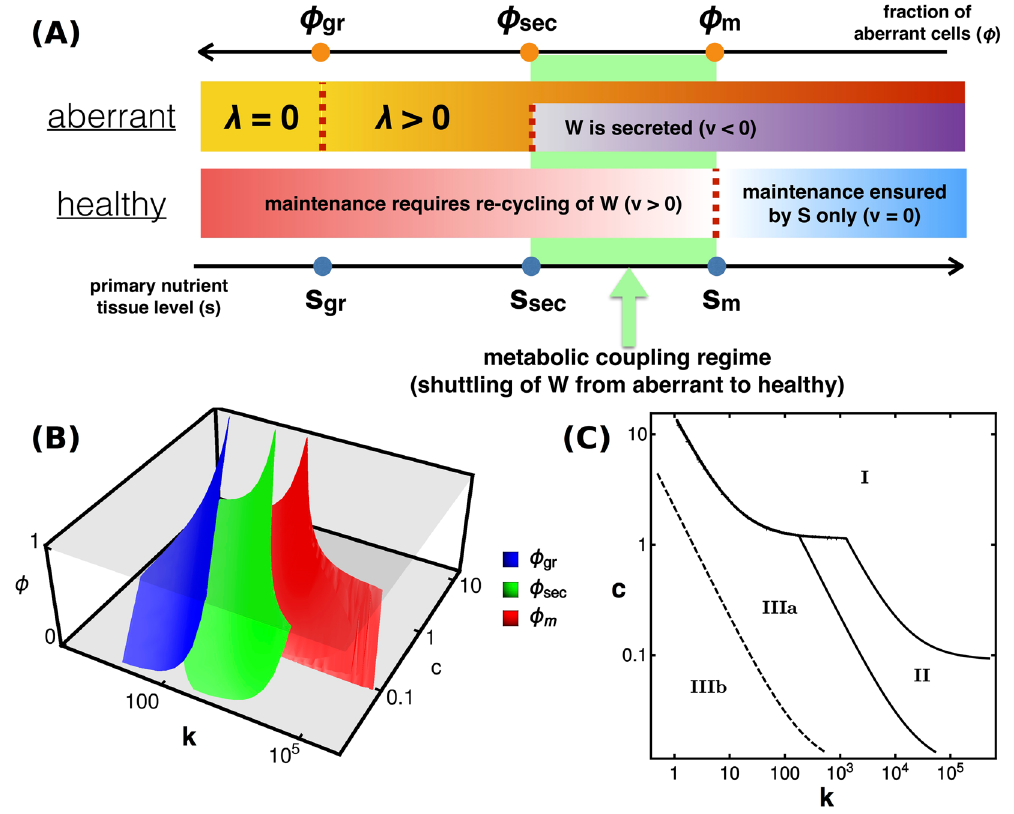
Figure 5. Summary of thresholds found in the spatially homogeneous model. ( A ) Aberrant cells can sustain a non-zero growth rate for s > s gr (or φ < φ gr ) and excrete waste for s > s sec (or φ < φ sec ). In turn, healthy cells need to re-cycle the waste in order to meet their maintenance goals when s < s m (or φ > φ m ). As a consequence, aberrant and healthy cells are coupled when s sec < s < s m (or φ m < φ < φ sec ). Note that the φ -axis (top) is reversed with respect to the s -axis (bottom). ( B ) φ gr , φ sec and φ m as functions of k and c . ( C ) Phase structure in terms of the asymptotic aberrant fraction φ f . In Region I, φ f ≤ φ m ; in Region II, φ m < φ f < φ sec ; in Region III, φ f ≥ φ sec . The dashed line subdivides III according to whether φ sec > 0 (Region IIIa) or φ sec ≤ 0 (Region IIIb). The phase labeled W + (resp. W − ) in the phase diagram shown in Fig. 4A coincides with Region I (resp. IIIb). Region Sh. is instead formed by Regions II and